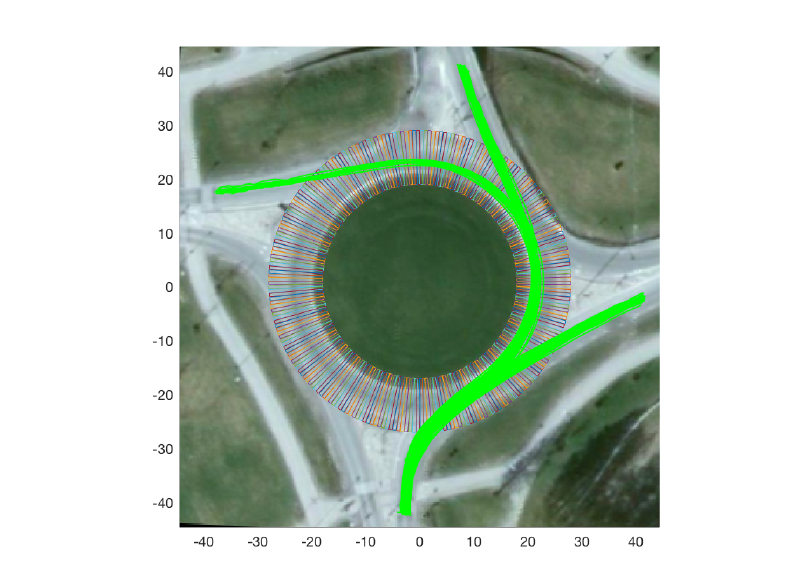
Figure 3. The grid discretising the physical space of interest at the roundabout (superimposed on sample trajectories originating from south and finishing in different